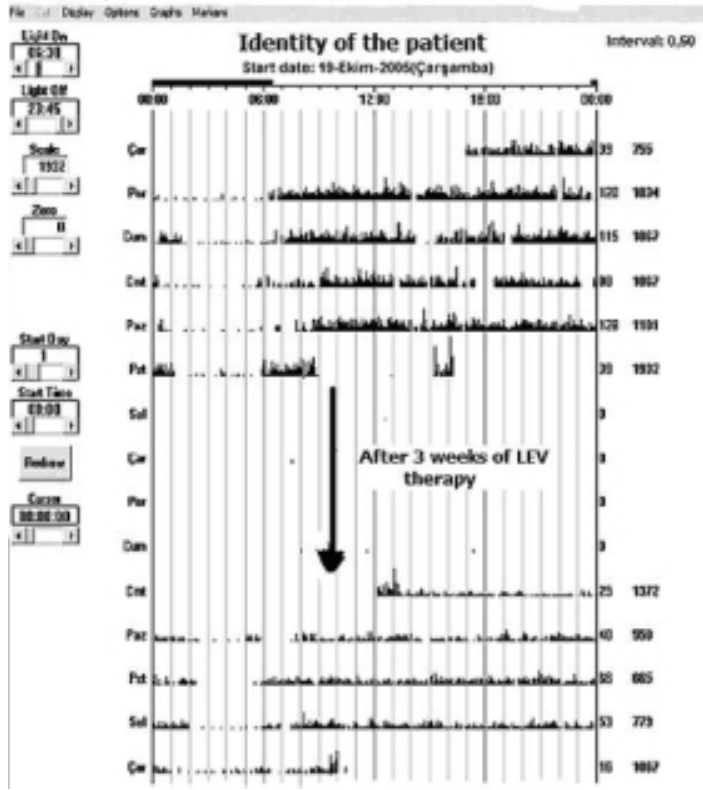
Fig. 1. A sample actogram. First period consists of 6 consecutive days pre-treatment and the second period consists of 5 consecutive days after three weeks of LEV monotherapy. Decreasing of total activity observed in the second period is noticeable. Activity counts are shown at the right side of